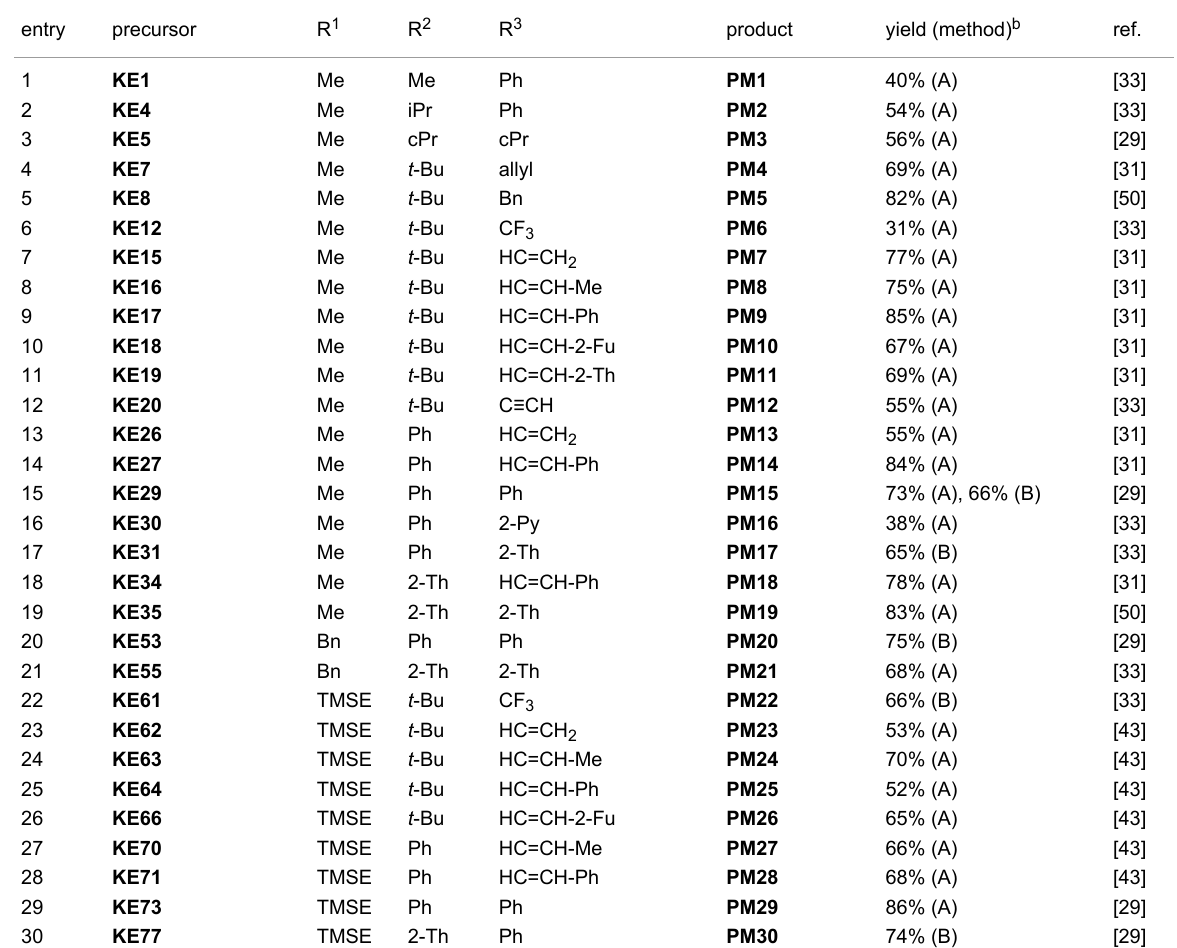
Table 4: Condensation of β -ketoenamides KE with ammonium salts to give pyrimidine derivatives PM1 – 30 according to Scheme 8. a